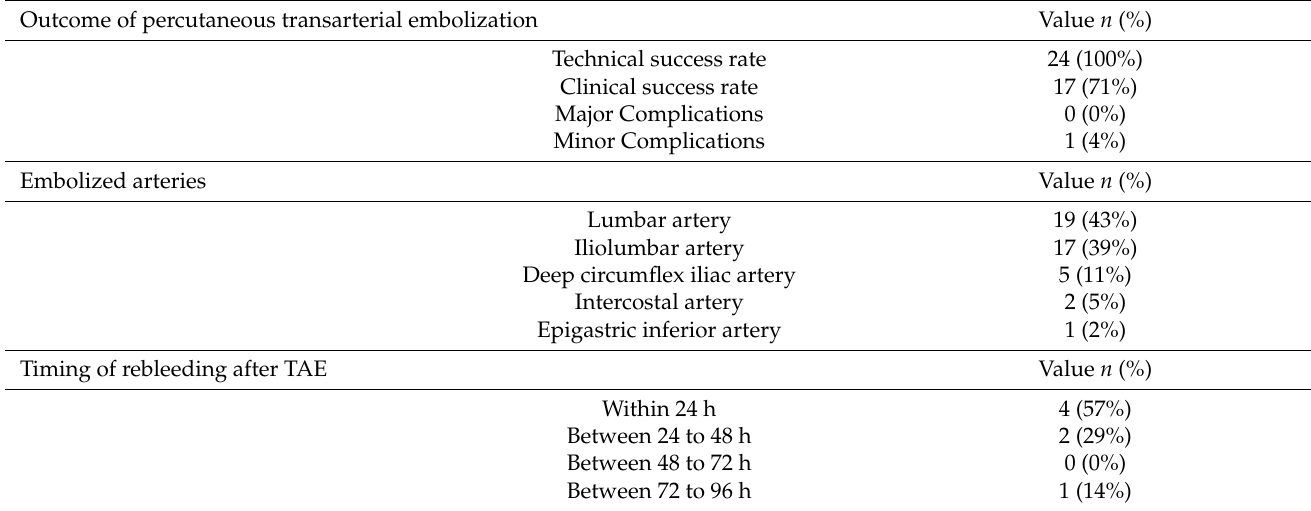
Table 2. Outcome of PTAE, embolized arteries, and timing of rebleeding after TAE. Outcome of percutaneous transarterial embolization Value n (%) Technical success rate 24 (100%) Clinical success rate